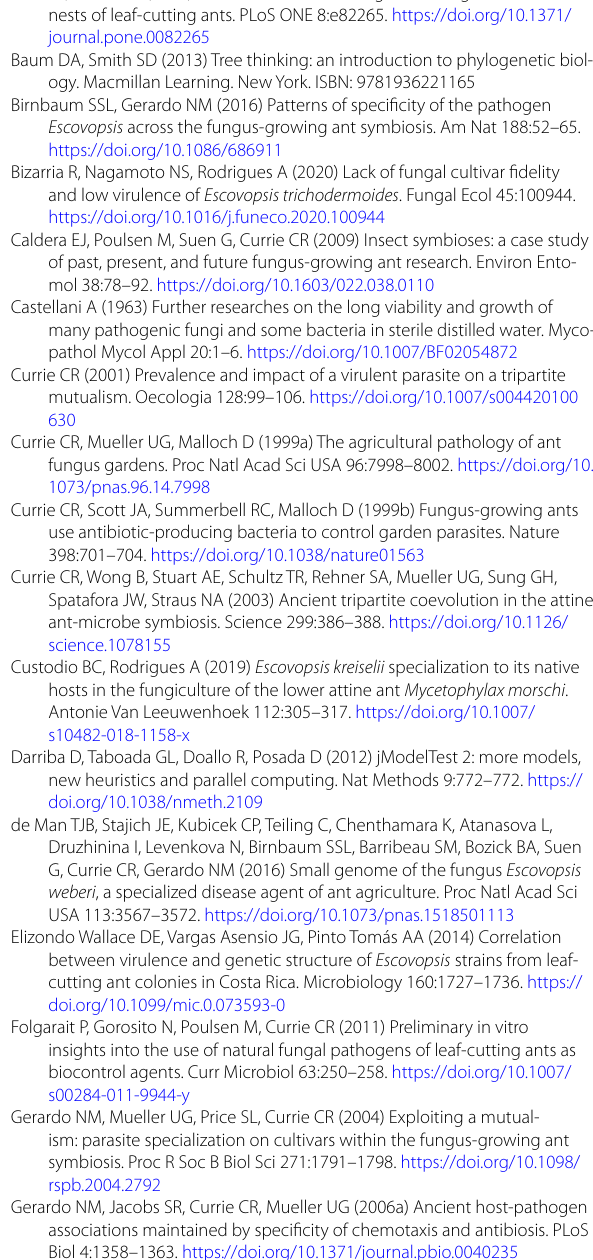
Additional file 3: Figure S2. Extended phylogenetic tree (from Fig. 1) indicating the placement of every isolate previously treated as Escovopsis . The tree shown was inferred using Bayesian Inference (BI). The tree gathers all available tef 1 sequences found in the literature and the data set used in this study, including the sequences of the nine Escovopsis ex-type cultures. The tree contains a total of 440 sequences which include: 274 strains of vesiculate- Escovopsis (Clade A), 105 strains of non-vesiculate Escovopsis (Clades B, C, D, E) and 60 strains from four genera, i.e., Escovopsioides , Hypomyces (along with species under its anamorphic genus Cladobot- ryum ), Protocrea , and Trichoderma , in the Hypocreaceae . Lecanicillium antillanum CBS 350.85 was used as the outgroup. Numbers on branches indicate BI posterior probabilities (PP) and Maximum Likelihood bootstrap support values (MLB), respectively. Hyphens (--) indicate MLB < 70%. There is only information, in the literature, on the colour of the colonies of the clades C and D, but the microscopic features of these clades are unknown. See Additional file 1: Table S3 for all strains and their associated metadata used to infer this phylogenetic